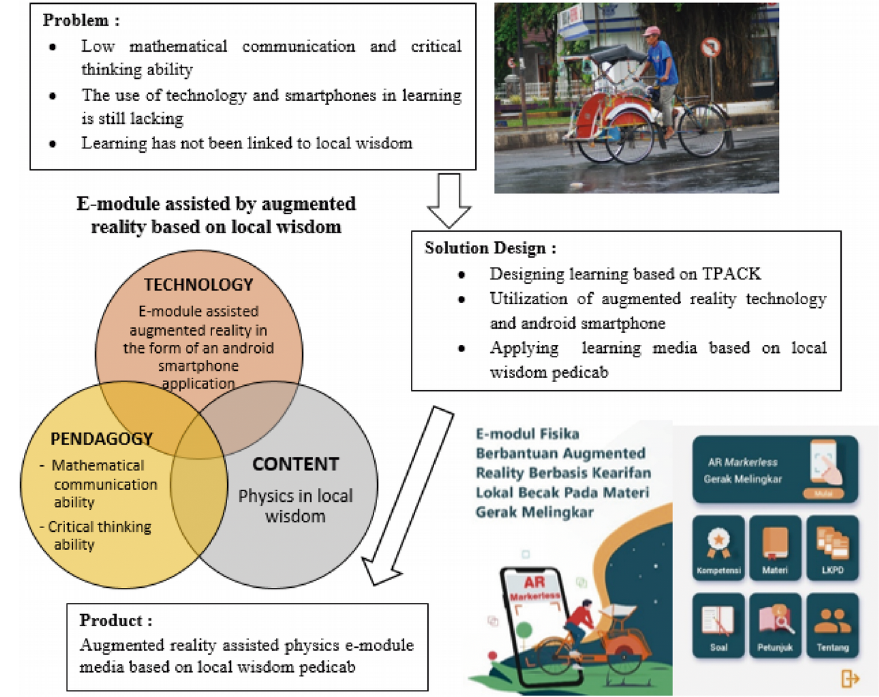
Figure 1. Problem solving